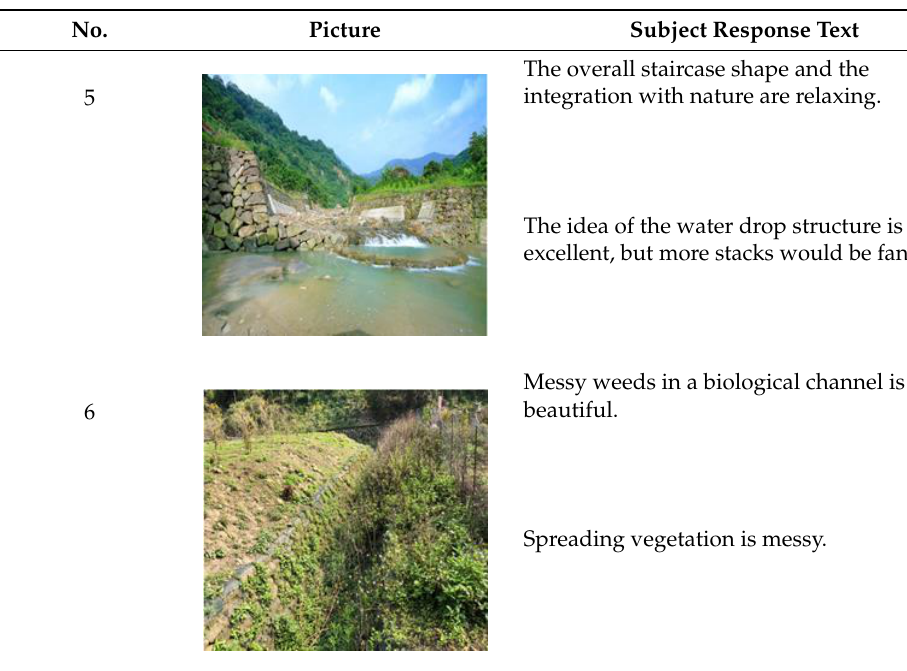
Table 11. CEM comparison of the highest and lowest SBE value images of the “Renovation Project of Sijiaolin Stream” .